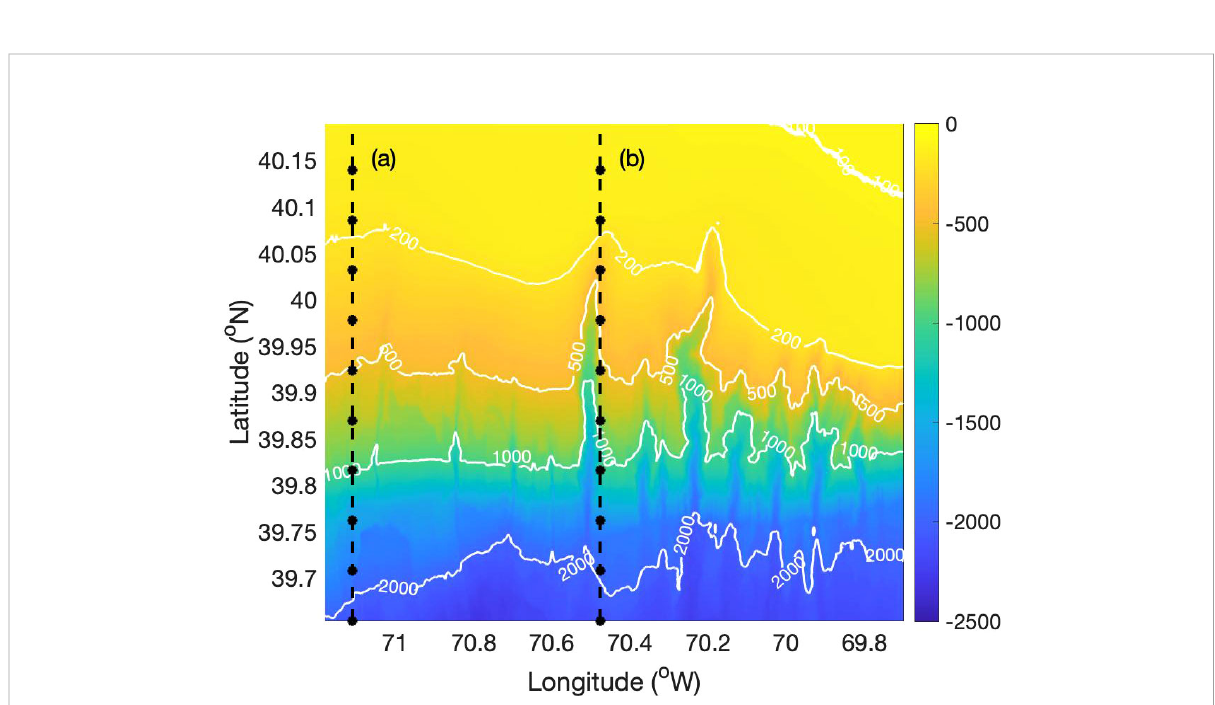
FIGURE 6 The two transects along latitude (A, B) and the bathymetry of the study